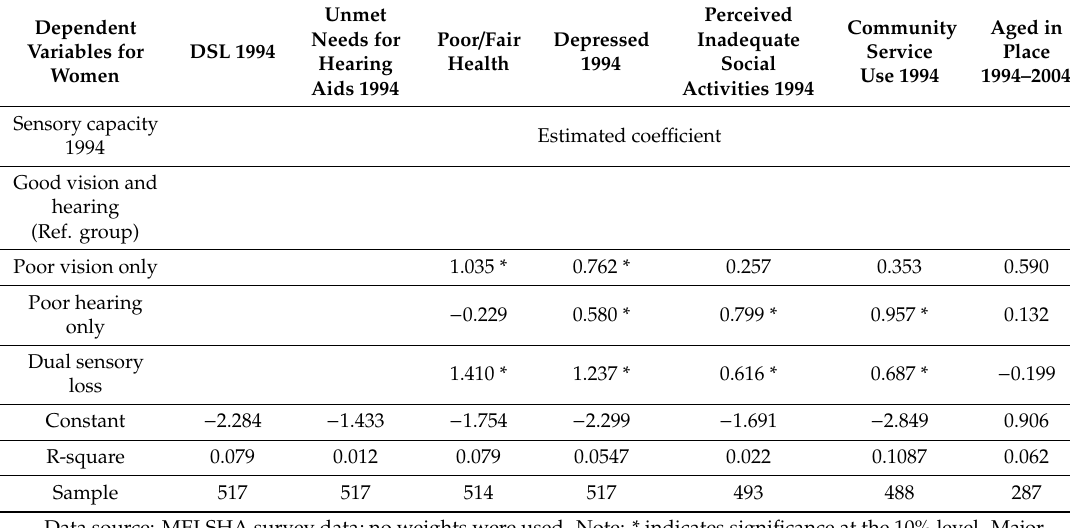
Table 8. Multivariate regression results on DSL prevalence and its associated outcomes in 1994 for women.